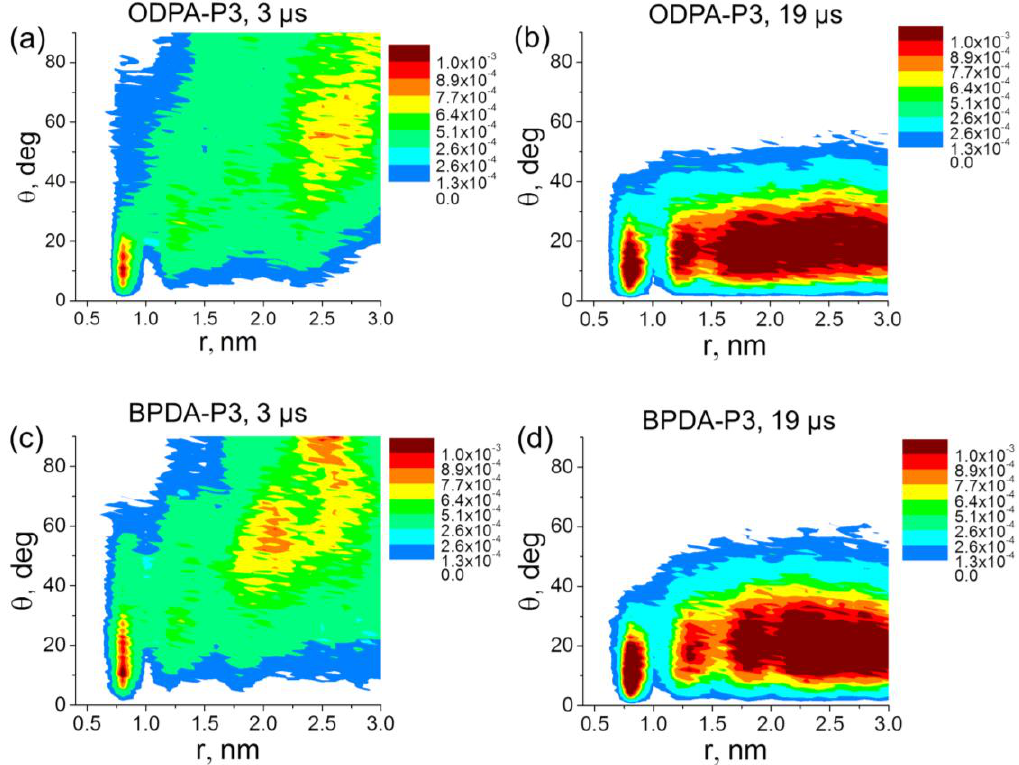
Figure 3. The distribution of the orientation angles θ for the vector P relative to the SWCNT axis in nanocomposites based on ODPA-P3 ( a , b ) and BPDA-P3 ( c , d ) after 3 µ s ( a , c ) and 19 µ s ( b , d ) of simulation. The results for ODPA-P3 have been calculated after 3 µ s of simulation and are taken for comparison from our previous study [30].